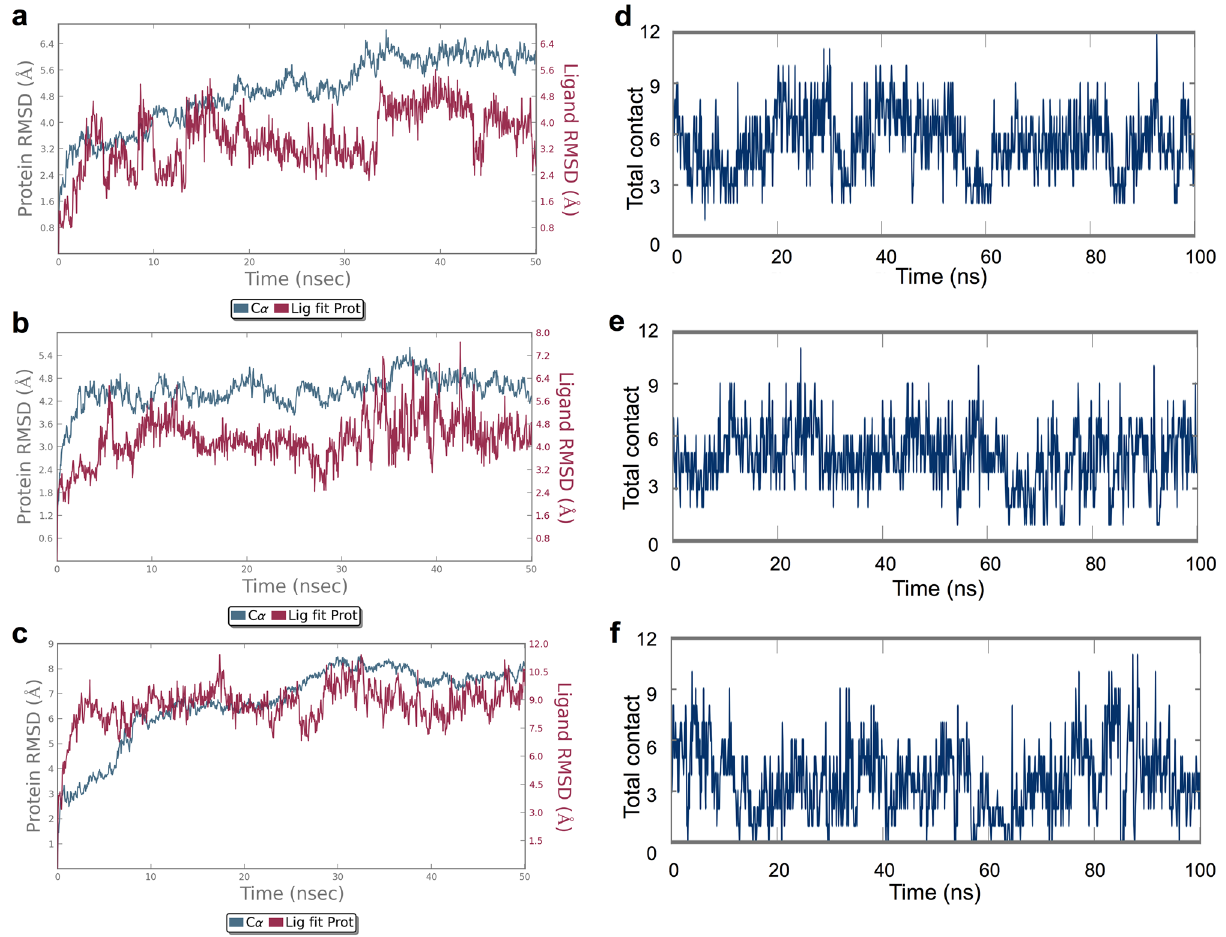
Figure 4. MD evaluation of the FaCOI1–FaJAZ1 complex with three different ligands. The RMSD of the Cα of the two proteins in the complex: FaCOI1–FaJAZ1 and JA-Ile ( a ), FaCOI1–FaJAZ1 and COR ( b ), and FaCOI1– FaJAZ1 and (−)-JA-Ile ( c ). Timeline representation of the total number of interactions or specific contacts (adding the H-bonds, hydrophobic interactions, ionic interactions, and water bridges) that the proteins made with the ligand throughout the MD simulation in FaCOI1–FaJAZ1 and JA-Ile ( d ), FaCOI1–FaJAZ1 and COR ( e ), FaCOI1–FaJAZ1 and (−)-JA-Ile ( f ). At, Arabidopsis thaliana ; Fa, Fragaria × ananassa ; COI1, CORONATINE INSENSITIVE1; COR, coronatine; JAZ, JASMONATE-ZIM